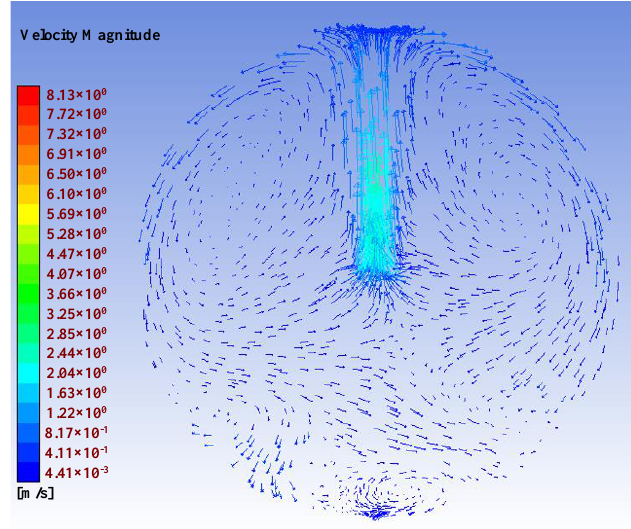
Figure 7. Flow field diagram when a single fan was placed on the central axis.